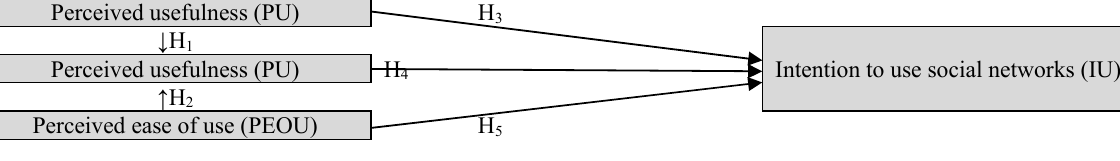
Fig. 1. The proposed